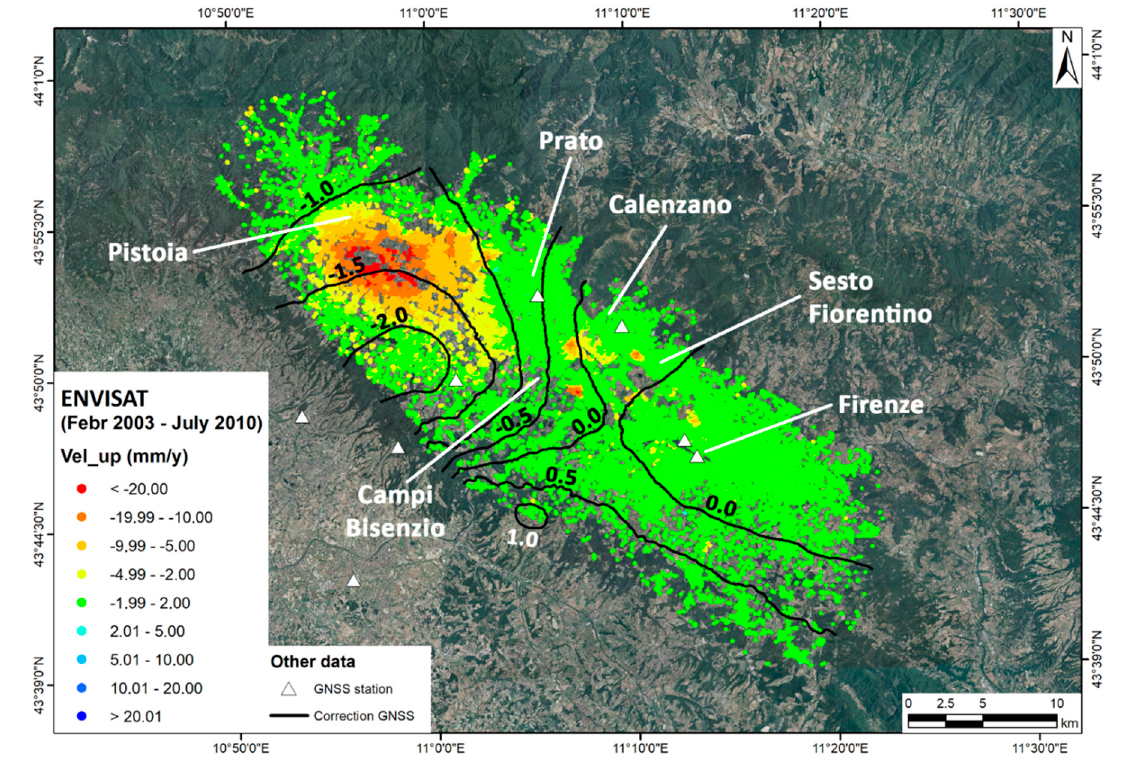
Figure 6. Corrected ENVISAT data (vertical velocity) and isolines of the correction values adopted for the vertical velocities.